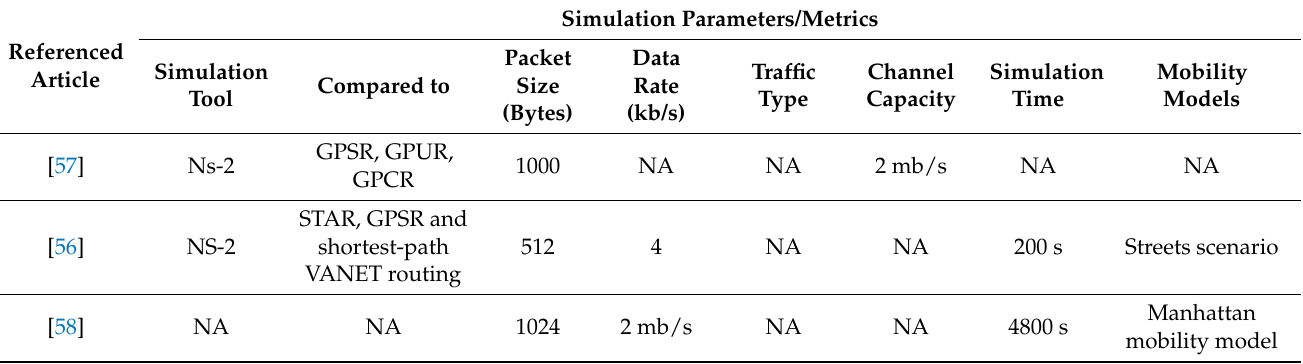
Table 18. Simulation parameters of urban scenario with streets-based routing protocols.